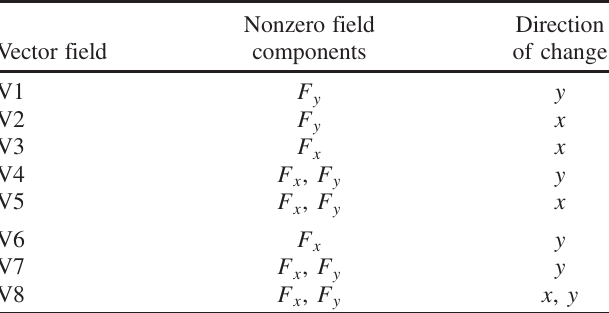
TABLE I. Features of vector field plots used in the eye-tracking study.